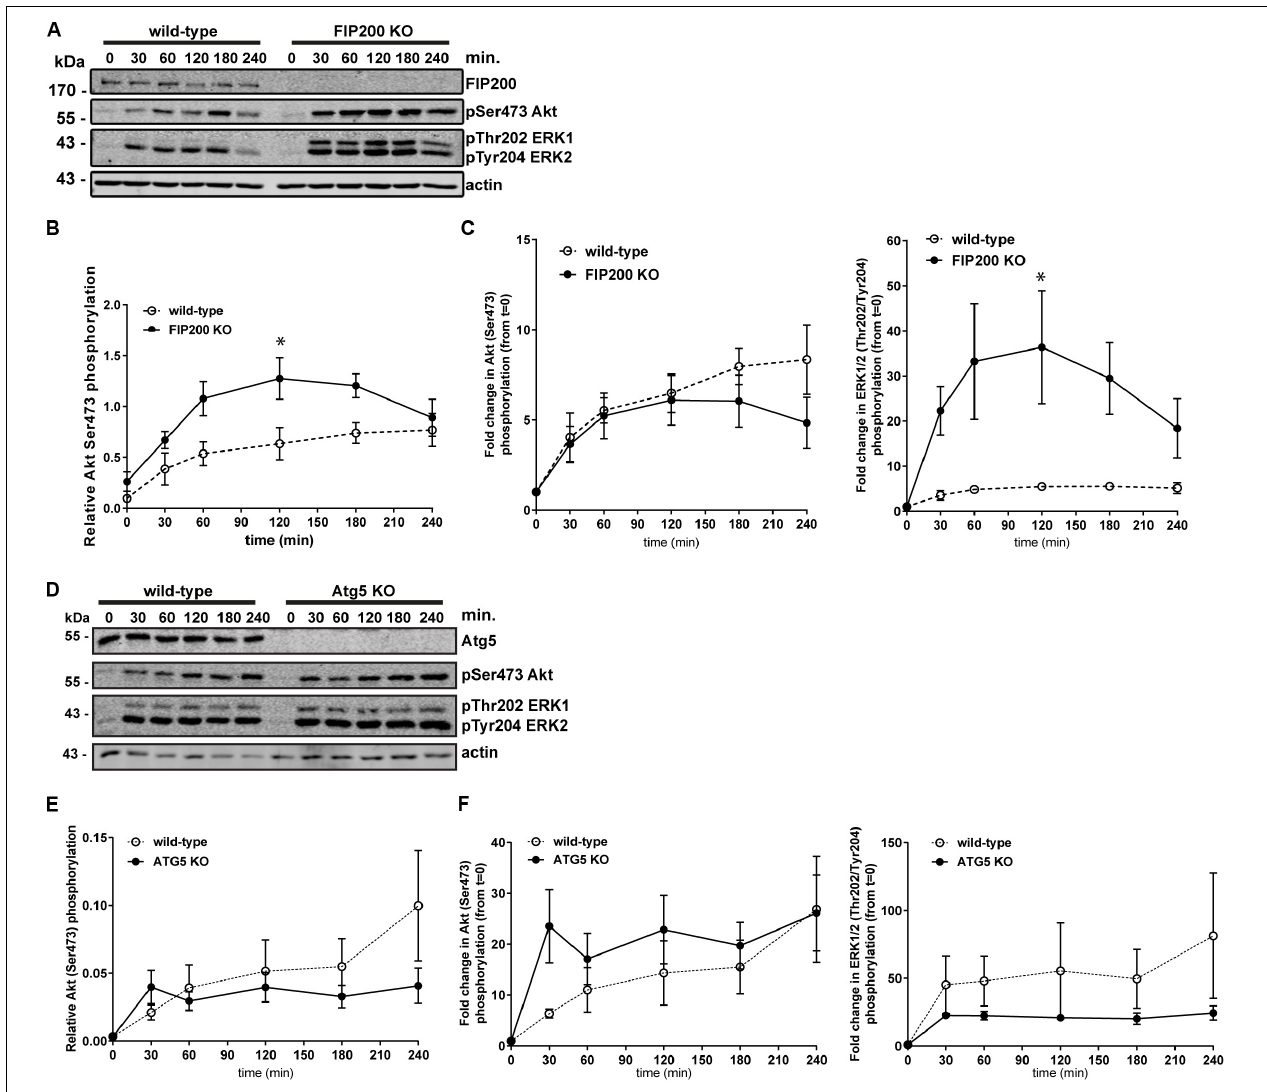
FIGURE 4 | Specific loss of FIP200 results in elevated phospo-ERK1/2 across the time course of fibronectin-induced cell spreading. (A) MCF10A wild-type and FIP200 KO cells were kept in suspension in EGF depleted growth media for 1 hour prior to plating on 10 µ g/ml fibronectin for the indicated times. Time zero indicates cells in suspension. Western blot analysis was performed on lysates harvested at the indicated times. Immunoblotting was performed against the indicated proteins. (B) Quantitation of Ser473 Akt phosphorylation western blot integrated density values normalized to actin from wild-type and FIP200 KO cells. (C) Fold change in Akt Ser473 or ERK1 Thr202 and ERK2 Tyr204 phosphorylation from zero time point following normalization to actin from wild-type and FIP200 KO cells. (D) MCF10A wild-type and Atg5 KO cells were kept in suspension in EGF depleted growth media for 1 hour prior to plating on 10 µ g/ml fibronectin for the indicated times. Time zero indicates cells in suspension. Western blot analysis was performed on lysates harvested at the indicated times. Immunoblotting was performed against the indicated proteins. (E) Quantitation of Ser473 Akt phosphorylation western blot integrated density values normalized to actin from wild-type and Atg5 KO cells. (F) Fold change in Akt Ser473 or ERK1 Thr202 and ERK2 Tyr204 phosphorylation from zero time point following normalization to actin from wild-type and Atg5 KO cells. Results represent at least 3 independent experiments and error bars are the SEM. * p <